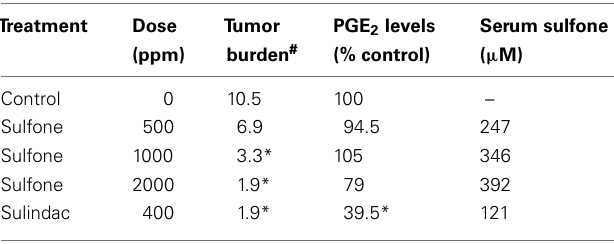
Table 2 | Inhibition of azoxymethane-induced colon tumorigenesis in rats by sulindac sulfone and sulindac